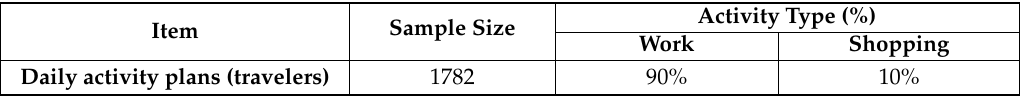
Table 1. Sample size characteristics *.